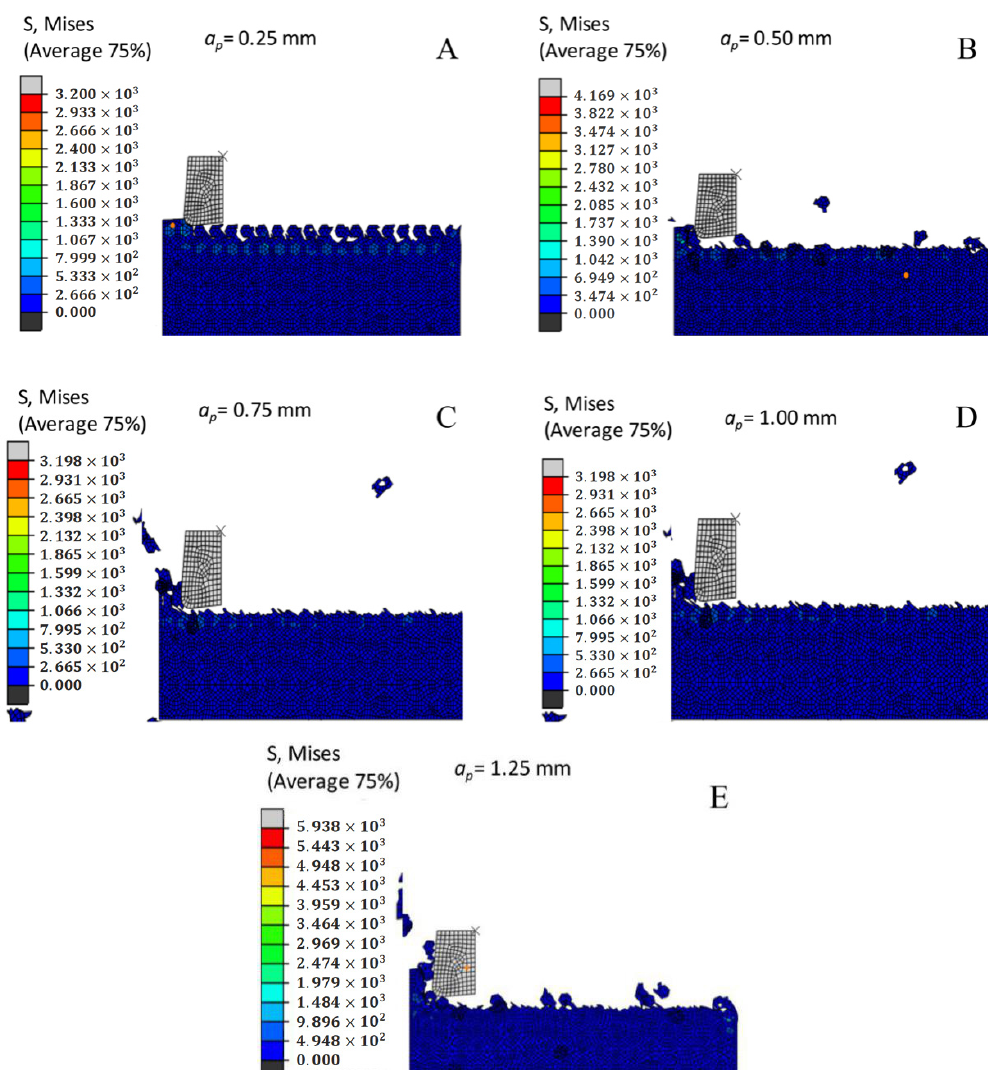
Figure 16. Chip morphology under different milling depths. ( A ) a p = 0.25 mm. ( B ) a p = 0.50 mm. ( C ) a p = 0.75 mm. ( D ) a p =